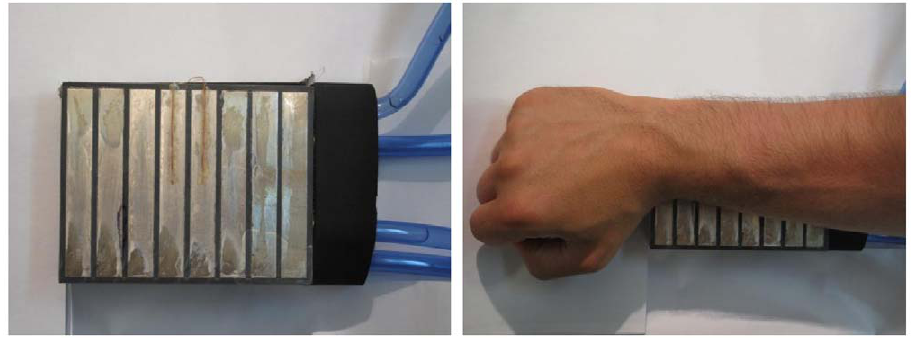
Figure 1. The thermal grill. The thermal grill consisted of 8 individual silver plates housed in a PVC unit. The subjects placed their ventral forearm against the grill’s surface, orthogonally to the long axis of the silver plates. Temperatures of odd and even numbered plates were set to 41.0 u C–42.0 u C and/or 15.0 u C–16.0 u C.